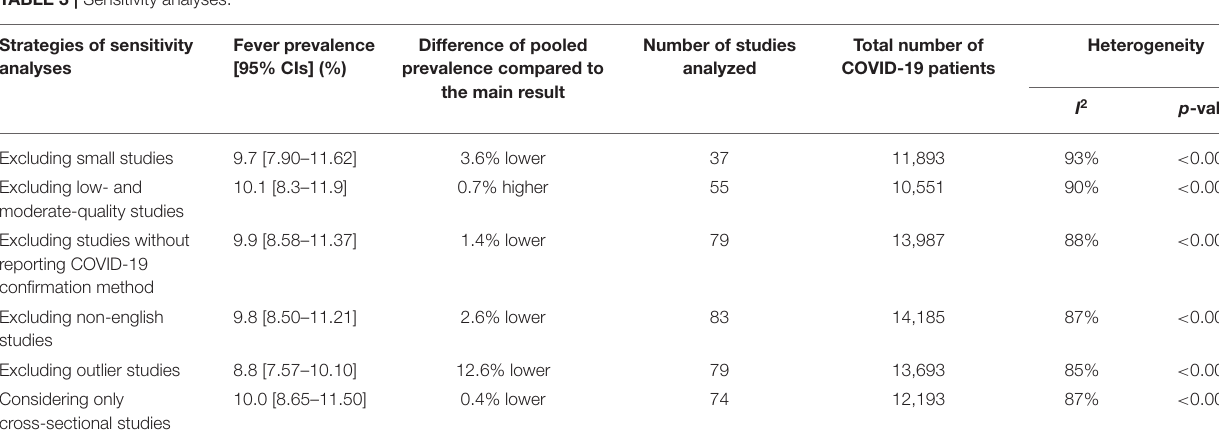
TABLE 3 | Sensitivity